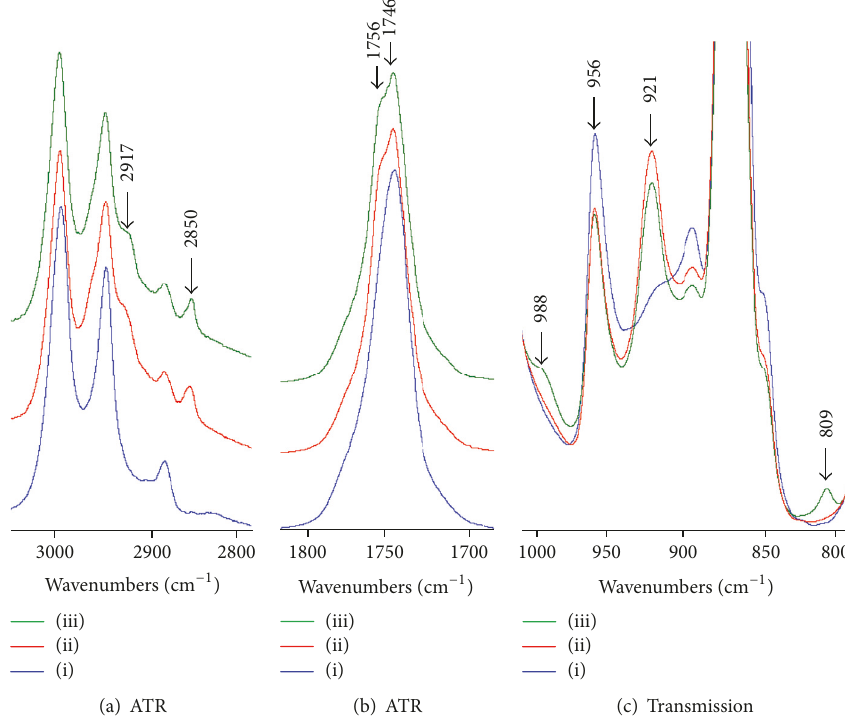
Figure 4: FTIR spectra of neat (i), blank (ii), and grafted PLA (iii) films in the C-H stretching vibrational region (a), the C=O stretching vibration region (b), and the skeletal vibration region (c), indicating changes in conformations and crystalline characteristics of the film